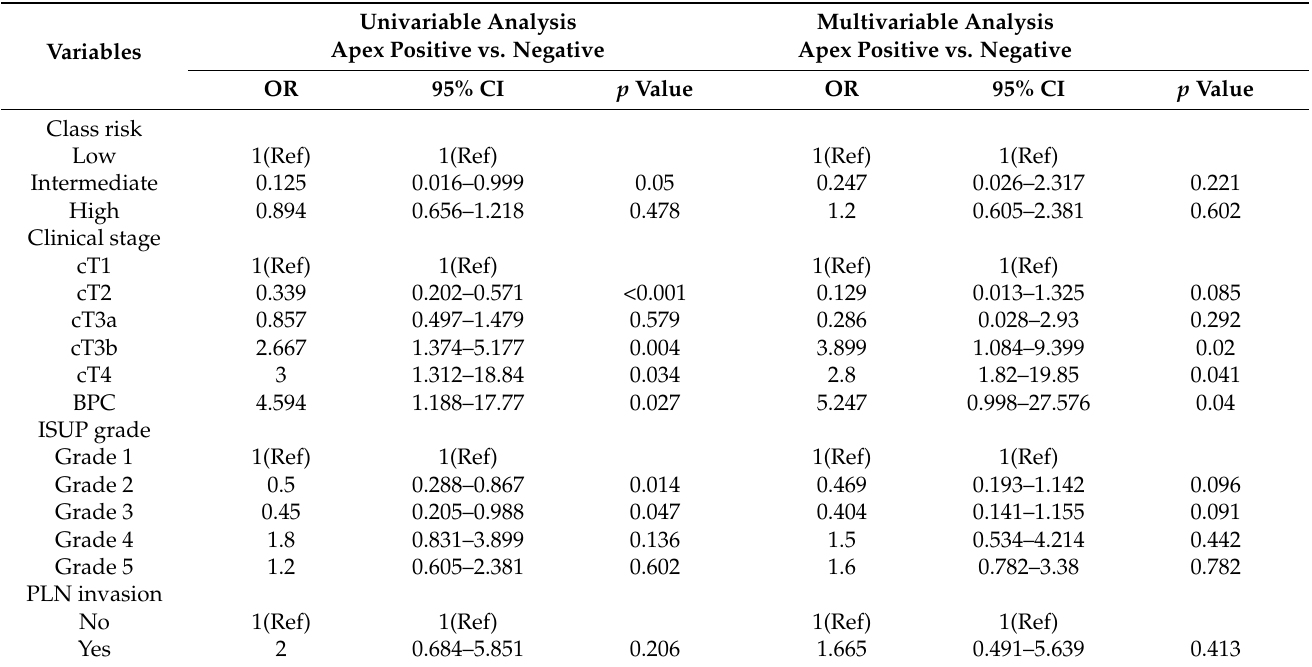
Table 4. Clinical and pathological factors associated with risk of positive apical margins by the binary logistic regression